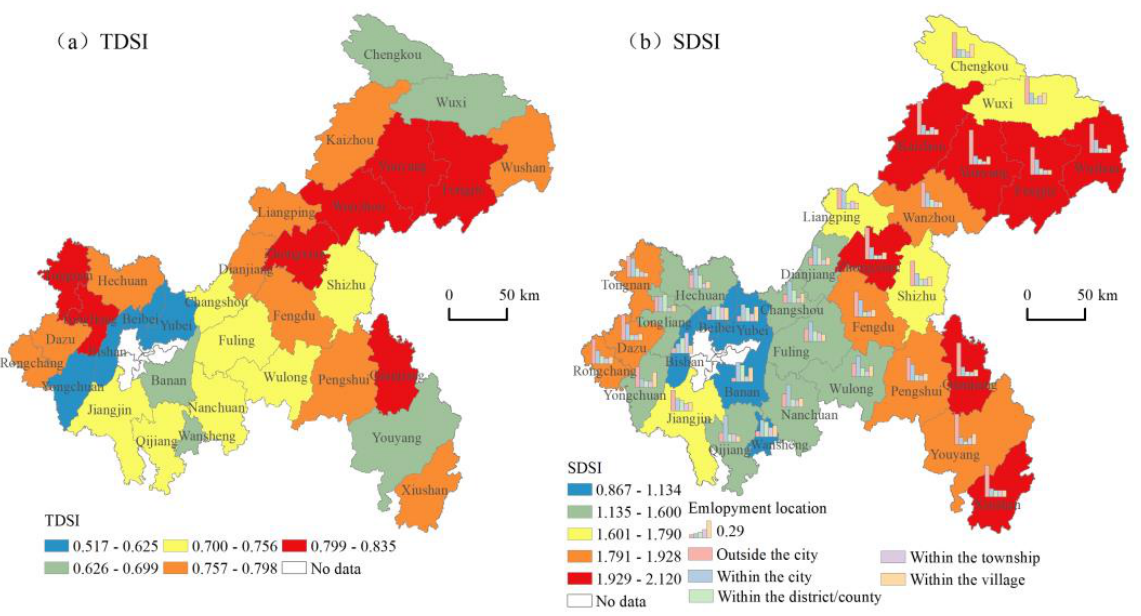
Figure 2. The spatial patterns of TDSI and SDSI in Chongqing. Notes: TDSI refers to the time dimension on the separation index, while SDSI refers to the spatial dimension separation index of the SDHJ .